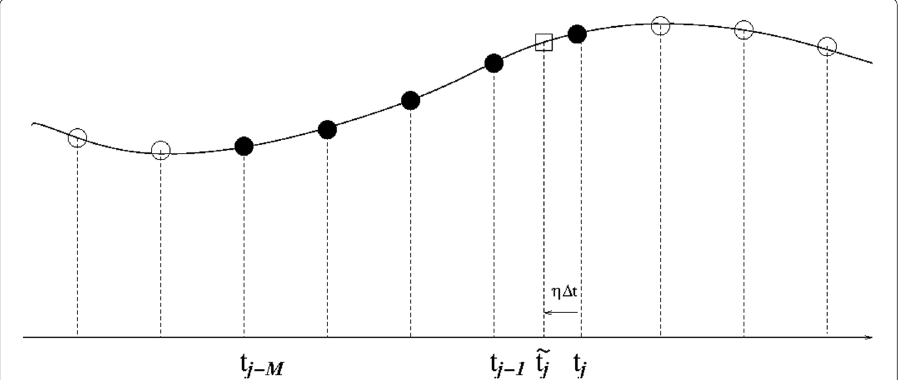
Fig. 2 A schematic diagram for a general interpolation stencil (denoted by closed circles) along the time grid for a point ˜ t j (denoted by the open square) between t j − 1 and t j . Open circles indicate the temporal grid